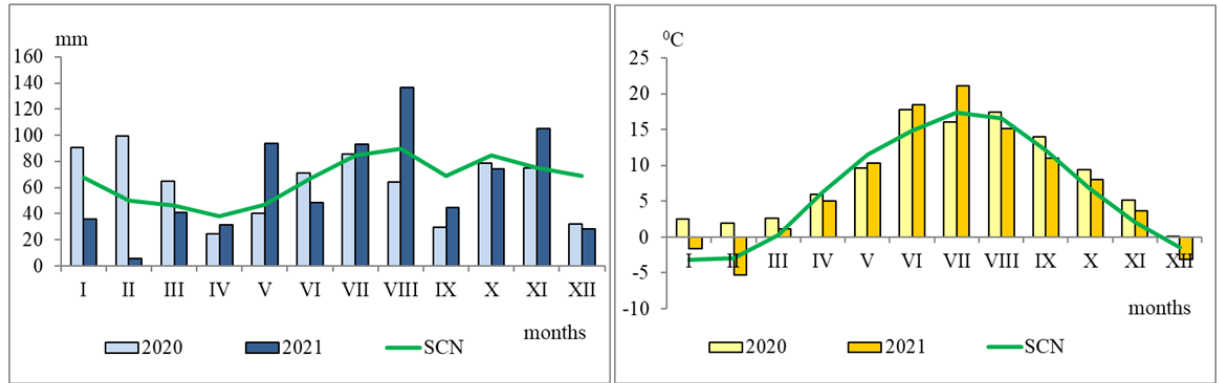
Figure 5. The average daily air temperature (°C) and precipitation (mm) during the study period (2020 – 2021). SCN — standard climate